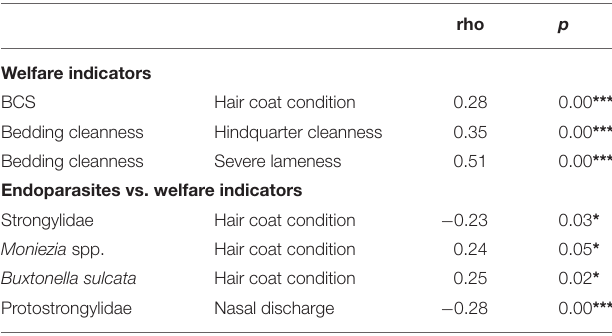
TABLE 7 | Spearman’s rank correlations between the welfare indicators and different